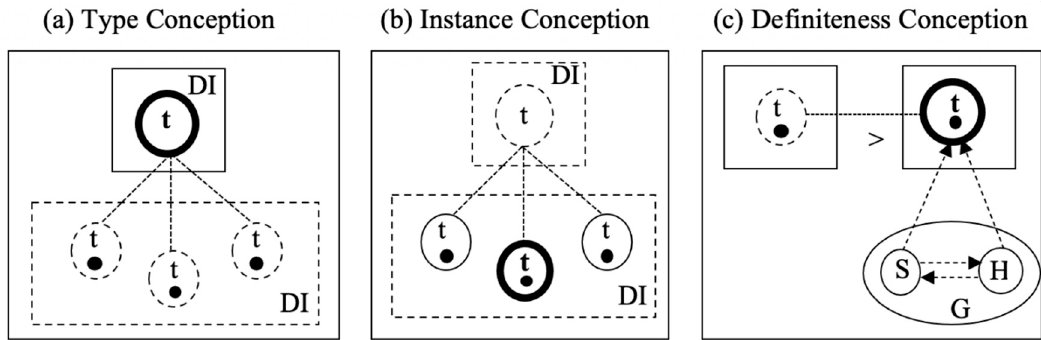
Figure 1. Schematic representations of conceptions of type, instance, and definiteness (Langacker 2008). S = Speaker; H = Hearer; G = Ground; DI = Domain of instantiation; t = type